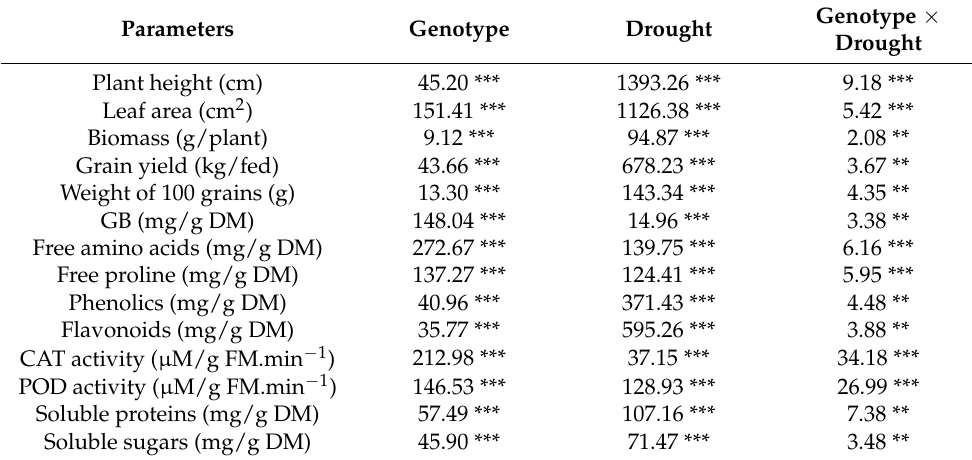
Table 2. Results of two-way ANOVA analysis.